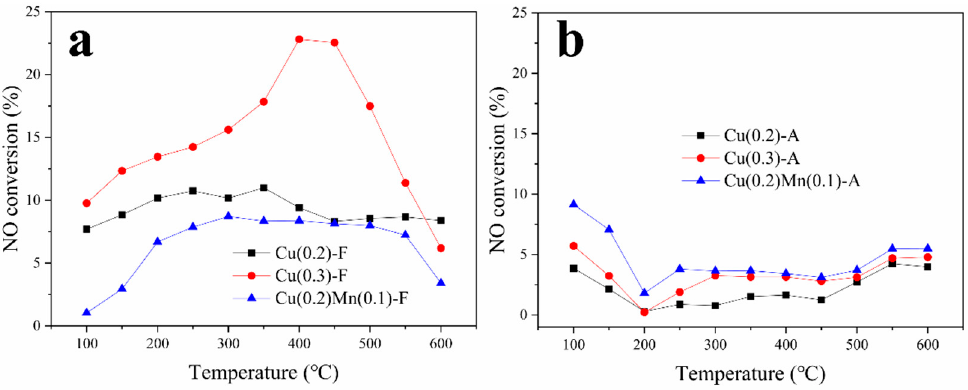
Figure 4. NO oxidation of catalysts before ( a ) and after ( b ) hydrothermal aging under a GHSV of 30,000 h − 1 .